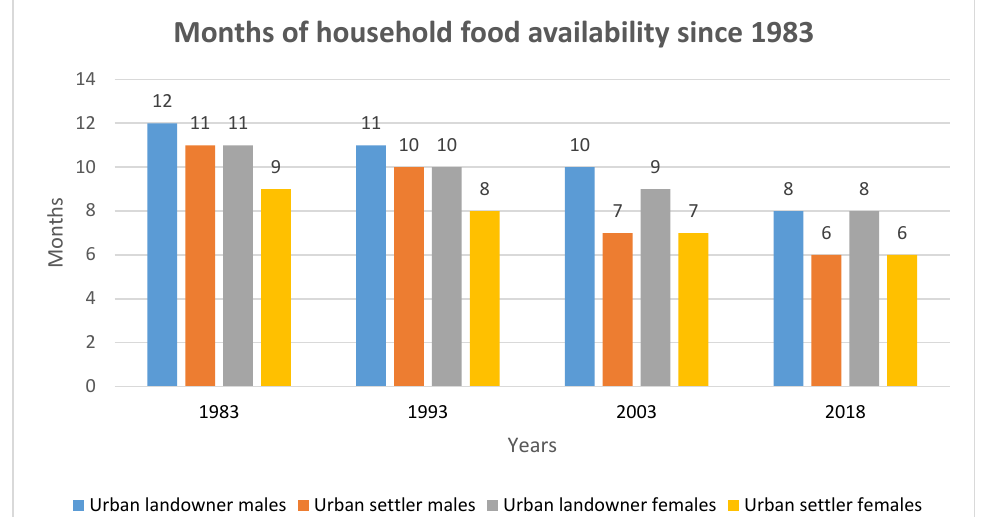
Figure 4. Annual household food availability in study area.